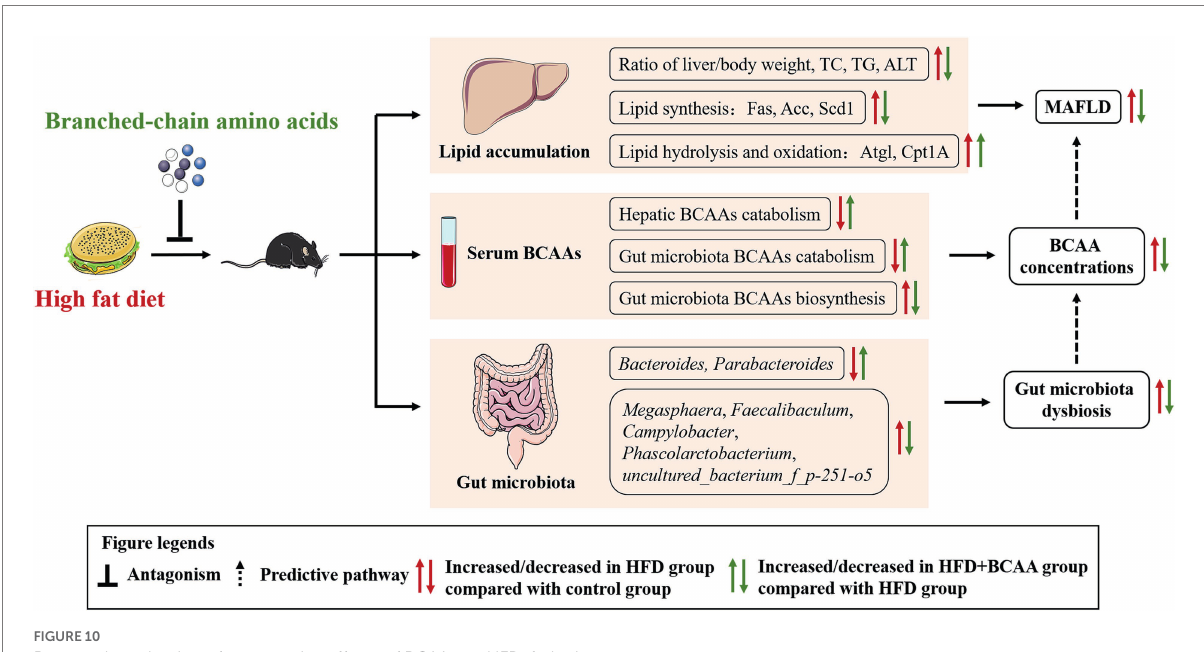
FIGURE 10 Proposed mechanisms for protective effects of BCAAs on HFD-fed